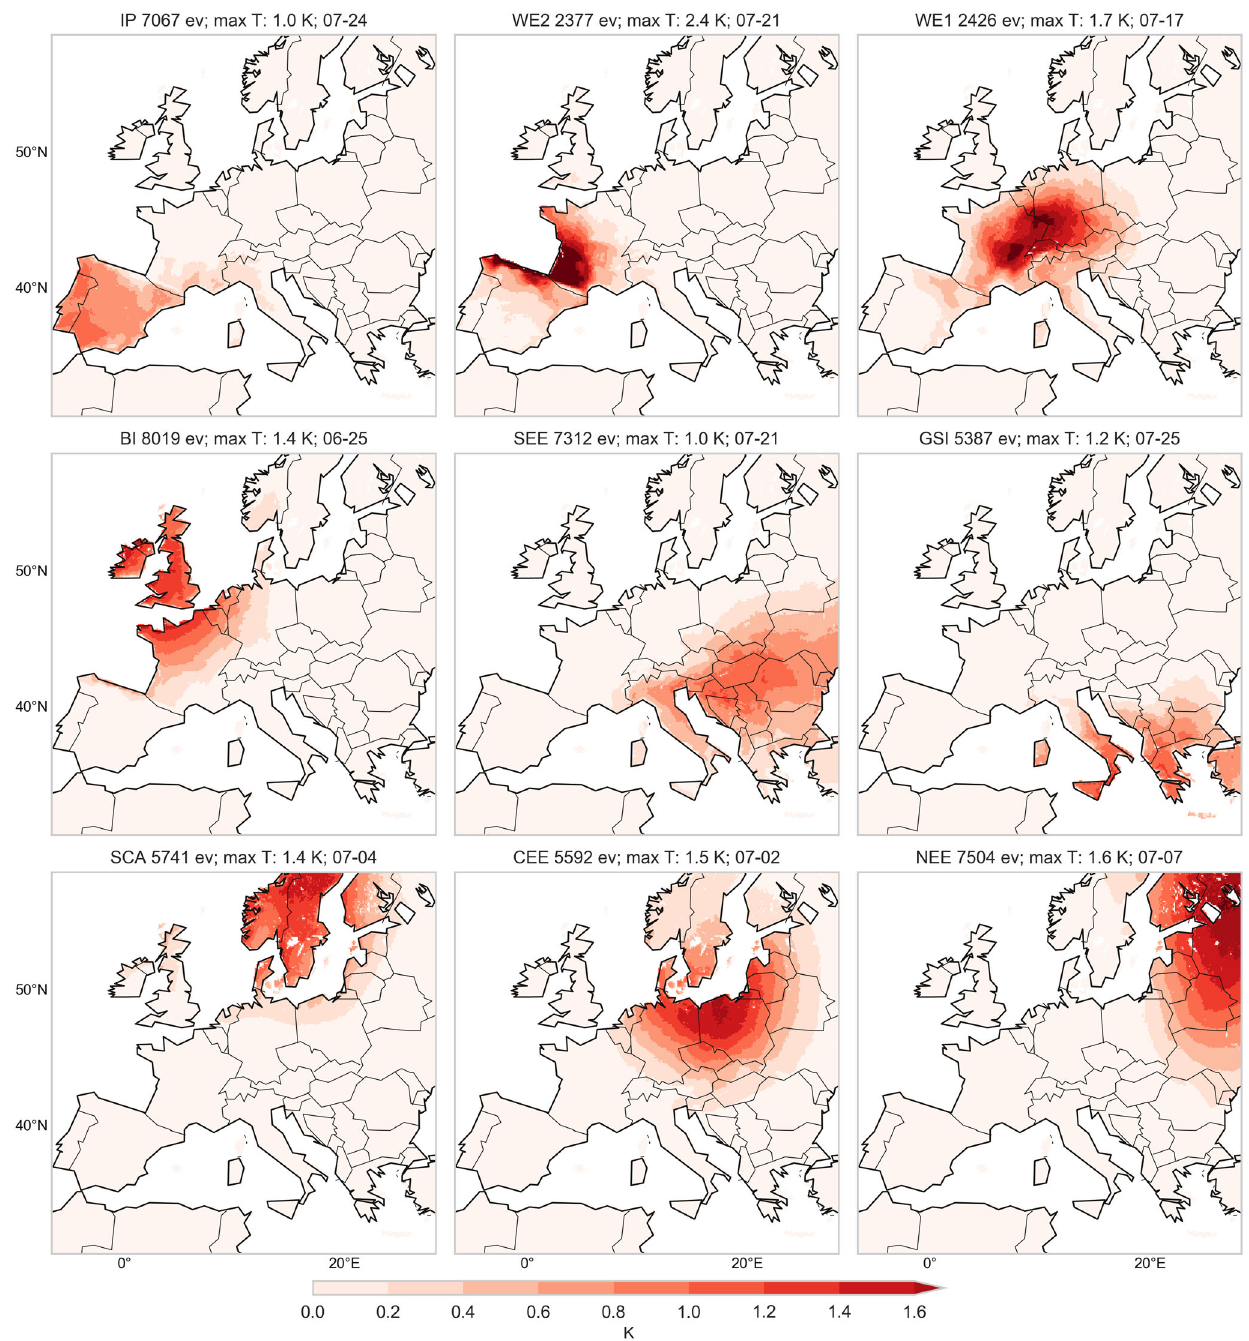
Fig. 1 Nine typical heatwave patterns over Europe derived from CRCM5-LE. Patterns obtained by hierarchical clustering of 1981-2010 Canadian Regional Climate Model 5 Large Ensemble (CRCM5-LE). In the title from left to right: pattern abbreviation, number of events belonging to the pattern (ev), mean maximum temperature in K, mean calendar day of the fi rst heatwave occurrence. From left to right, from top to bottom: IP: Iberian Peninsula, WE2: Western Europe 2, WE1: Western Europe 1, BI: Britain and Ireland, SEE: South-Eastern Europe, GSI: Greece/Southern Italy, SCA: Scandinavia, CEE: Central/Eastern Europe, NEE: North-Eastern